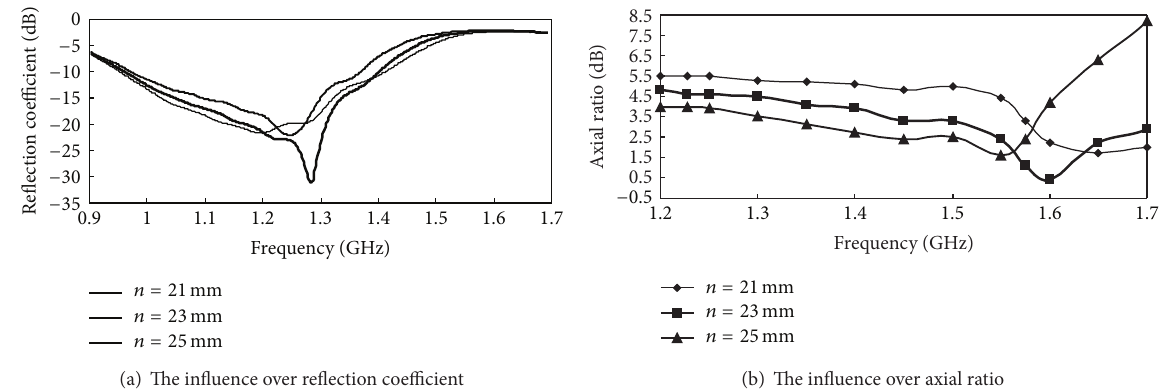
Figure 3: The influence of parameters 𝑛 over the antenna performance.